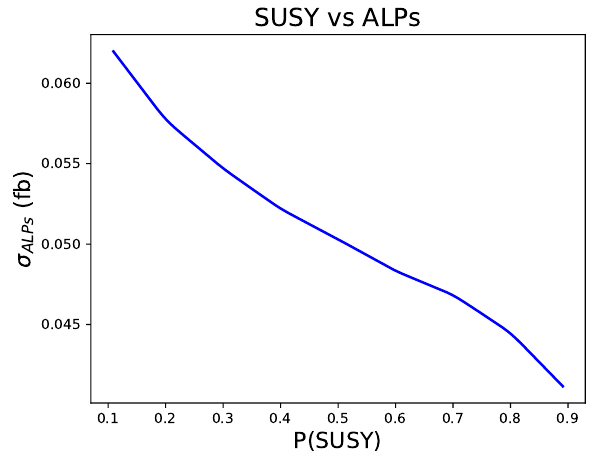
= 0.1 fb and S SUSY